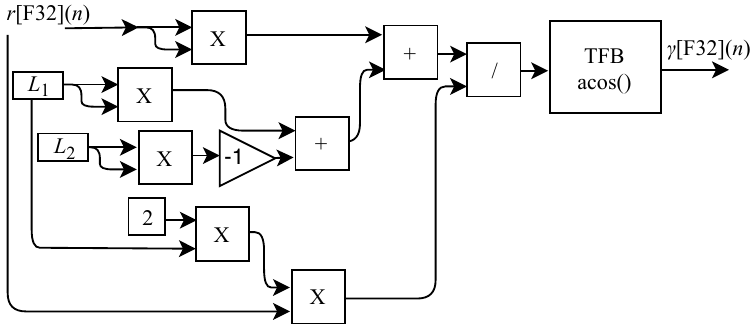
Figure 14. Proposed circuit to perform the calculation of γ [ F 32 ]( n ) (Equation (21))—IK-HSD.